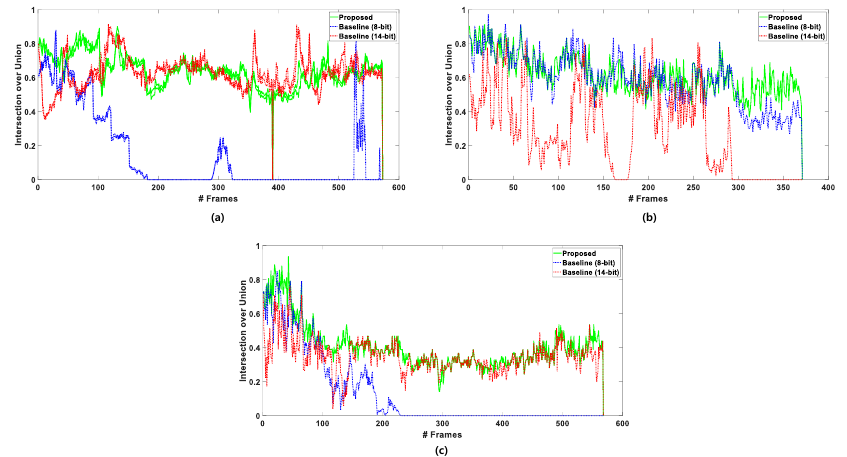
Figure 13. Intersection over union (IOU) of each video sequence: ( a ) IOU (Figure 11a), ( b ) IOU (Figure 11b), and ( c ) IOU (Figure 11c).